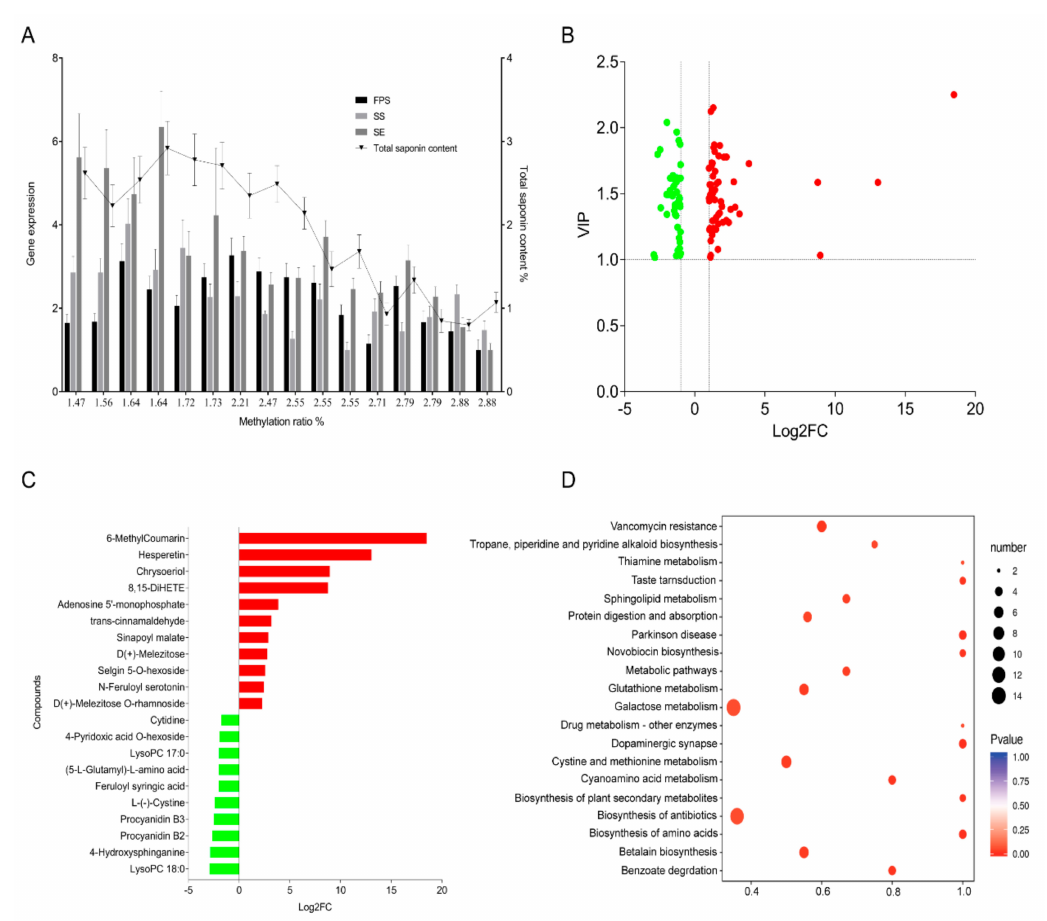
Figure 2. ( A ), E ff ect of the methylation of E. senticosus FPS , SS , and SE DNA on the DNA expression level and saponin content. ( B ), Volcano diagram of the metabolites with di ff erent metabonomic characteristics in E. senticosus high and low DNA methylation groups. Green represents downregulated di ff erentially expressed metabolites, and red represents upregulated di ff erentially expressed metabolites. ( C ), Histogram of significant di ff erences in metabolite di ff erence multiplicity between the metabolite groups in the E. senticosus high and low DNA methylation groups ( p < 0.01). Green represents downregulated di ff erentially expressed metabolites, and red represents upregulated di ff erentially expressed metabolites. ( D ), Enrichment diagram of KEGG, showing metabolites with di ff erent metabonomic characteristics in the E. senticosus high and low DNA methylation groups. The abscissa indicates the rich factor corresponding to each channel, the ordinate indicates the channel name, and the color of the point indicates the p -value: the redder, the greater the enrichment. The size of the dot represents the number of enriched di ff erential